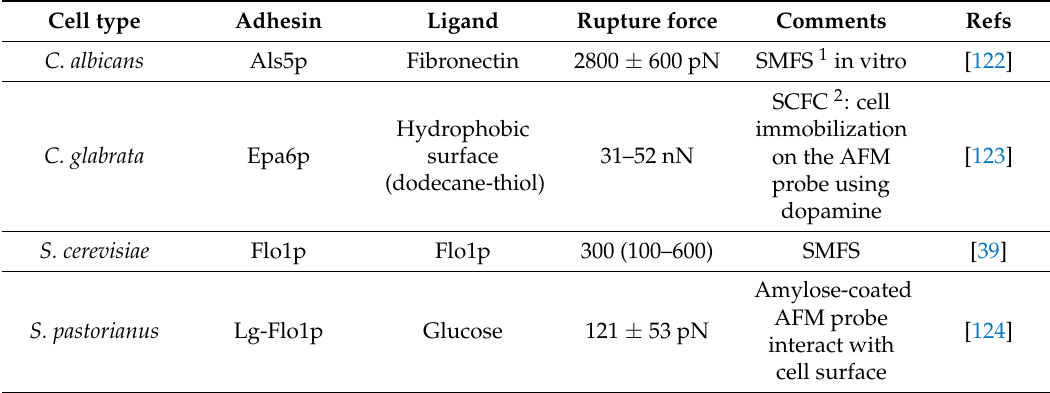
Figure 7. Molecular flocculation model based on Flo1p homophilic self-interaction. The two populations of N-Flo1p, which carry different types of N-glycans, are illustrated. Two S. cerevisiae cells bind together via Flo1p self-interaction. This binding is accomplished via lectin-glycan and glycan-glycan interactions. ( A ) 36 kDa of N-Flo1p containing two short core type N-glycans (Man 8-14 GlcNAc oligosaccharides) and one large hyperglycosylated type N-glycans (Man >50 GlcNAc). ( B ) 100 kDa of N-Flo1p containing one short core type and two large hypermannosylated type N-glycans. ( C ) Lectin–protein interaction. ( D ) Glycan-glycan interaction. Reprinted from [39]. Table 3. Yeast adhesin–ligand interaction forces. Adapted from [121].